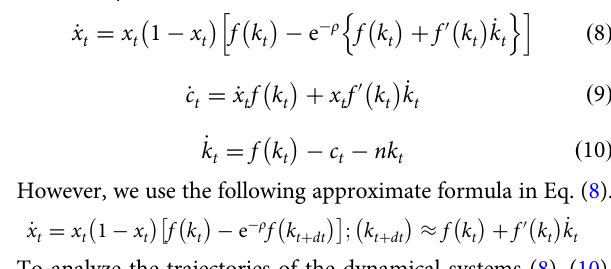
Procedure 2: Study . In management accounting practice, house- holds generally recognize the difference between the current period consumption level c e t planned in the previous period t − 1